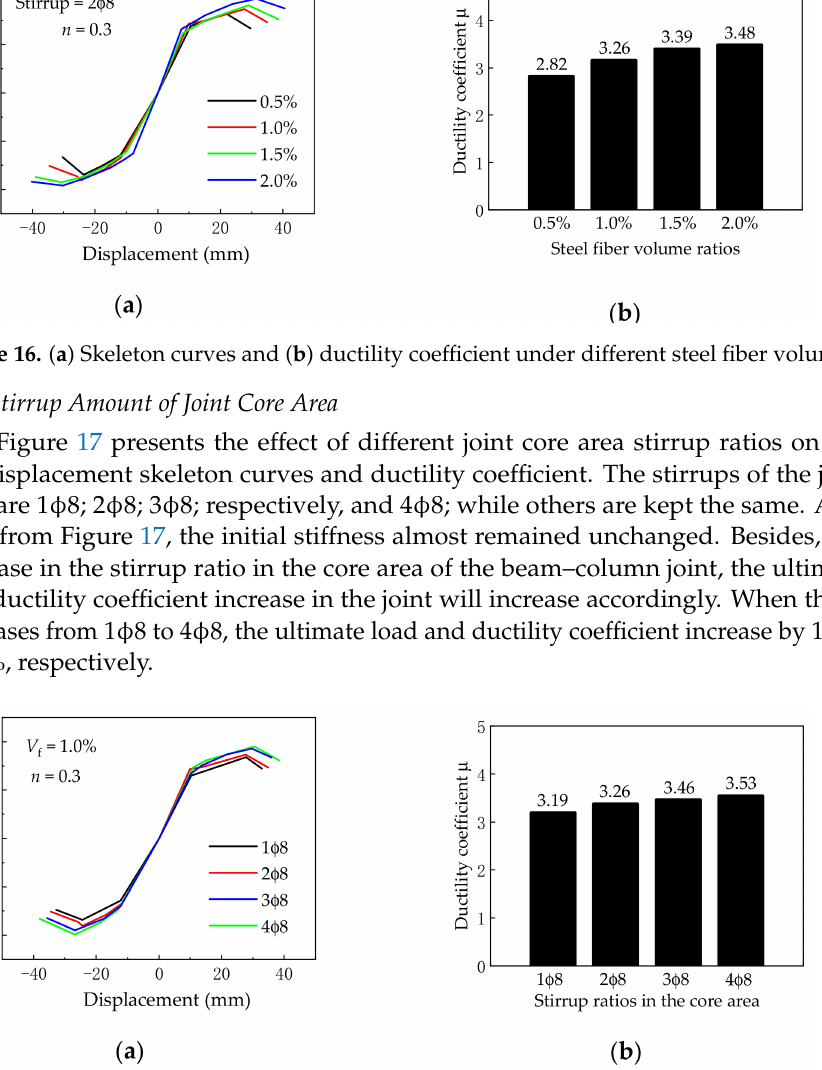
Figure 17. ( a ) Skeleton curves and ( b ) ductility coefficient under different stirrup ratios in the core area of